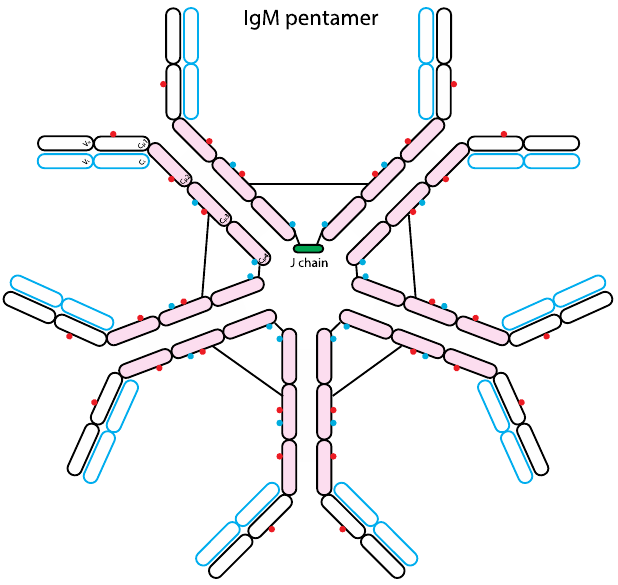
Figure 4. Schematic representation of the human IgM structure. IgM protein is comprised of two heavy chains (black outline) and two light chains (blue outline). Similar to IgE, each IgM heavy chain has the variable region (V ) and the constant region containing 4 H domains (Cµ1-4). Each light chain has variable (V ) and constant regions (C ). IgM L L molecule can be divided into antigen-binding fragment (Fab; empty ovals) and fragment crystallizable region (Fc; pink ovals). The red and blue dots represent N-linked glycans of complex-type and oligomannose-type, respectively. The black lines represent inter-chain disulfide bridges. Typically, IgM forms a pentamer or hexamer in circulation and only the pentameric form has a single J